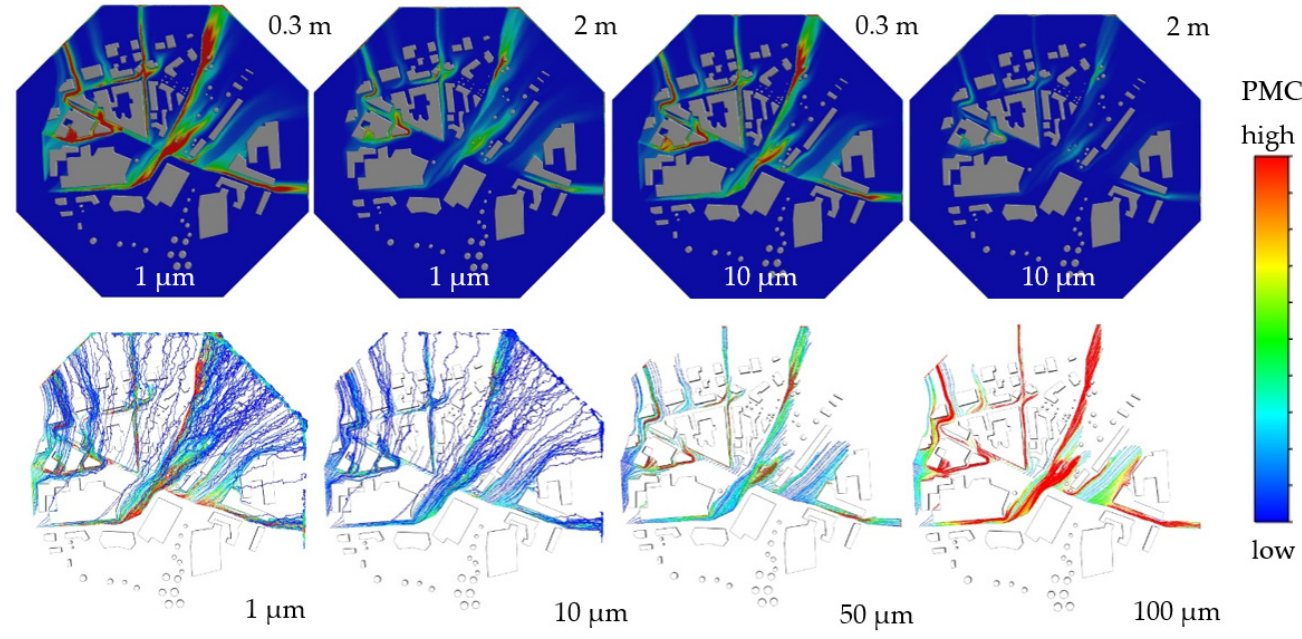
Figure 6. Particle dispersion after injection on the roadways. Above: particle trajectories according to the viewing height coloured by PMC (particle mass concentration). Below: particle trajectories according to the particle size coloured by PMC.